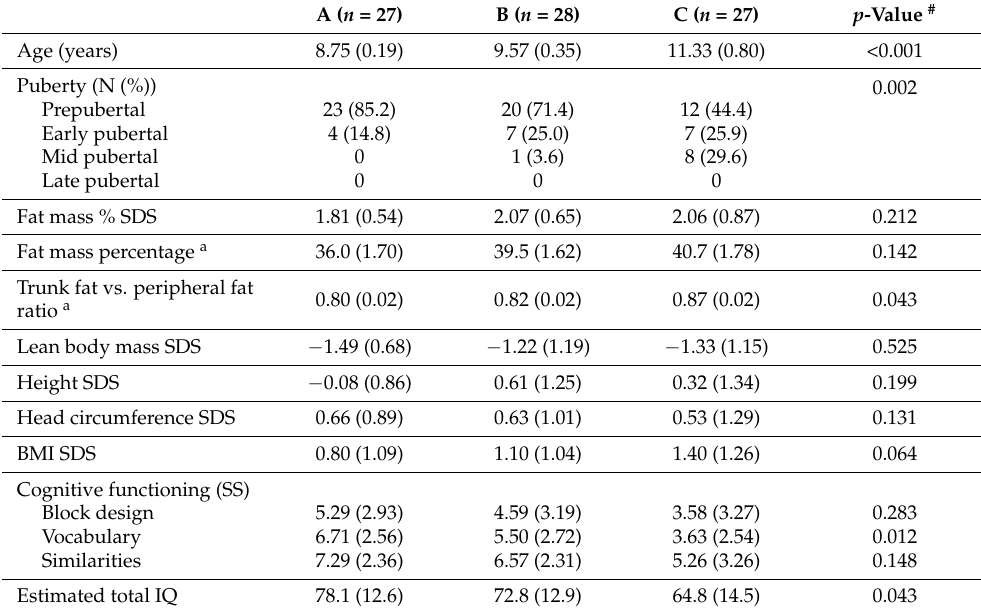
Table 3. Results after 8 years of GH treatment in the subgroups.